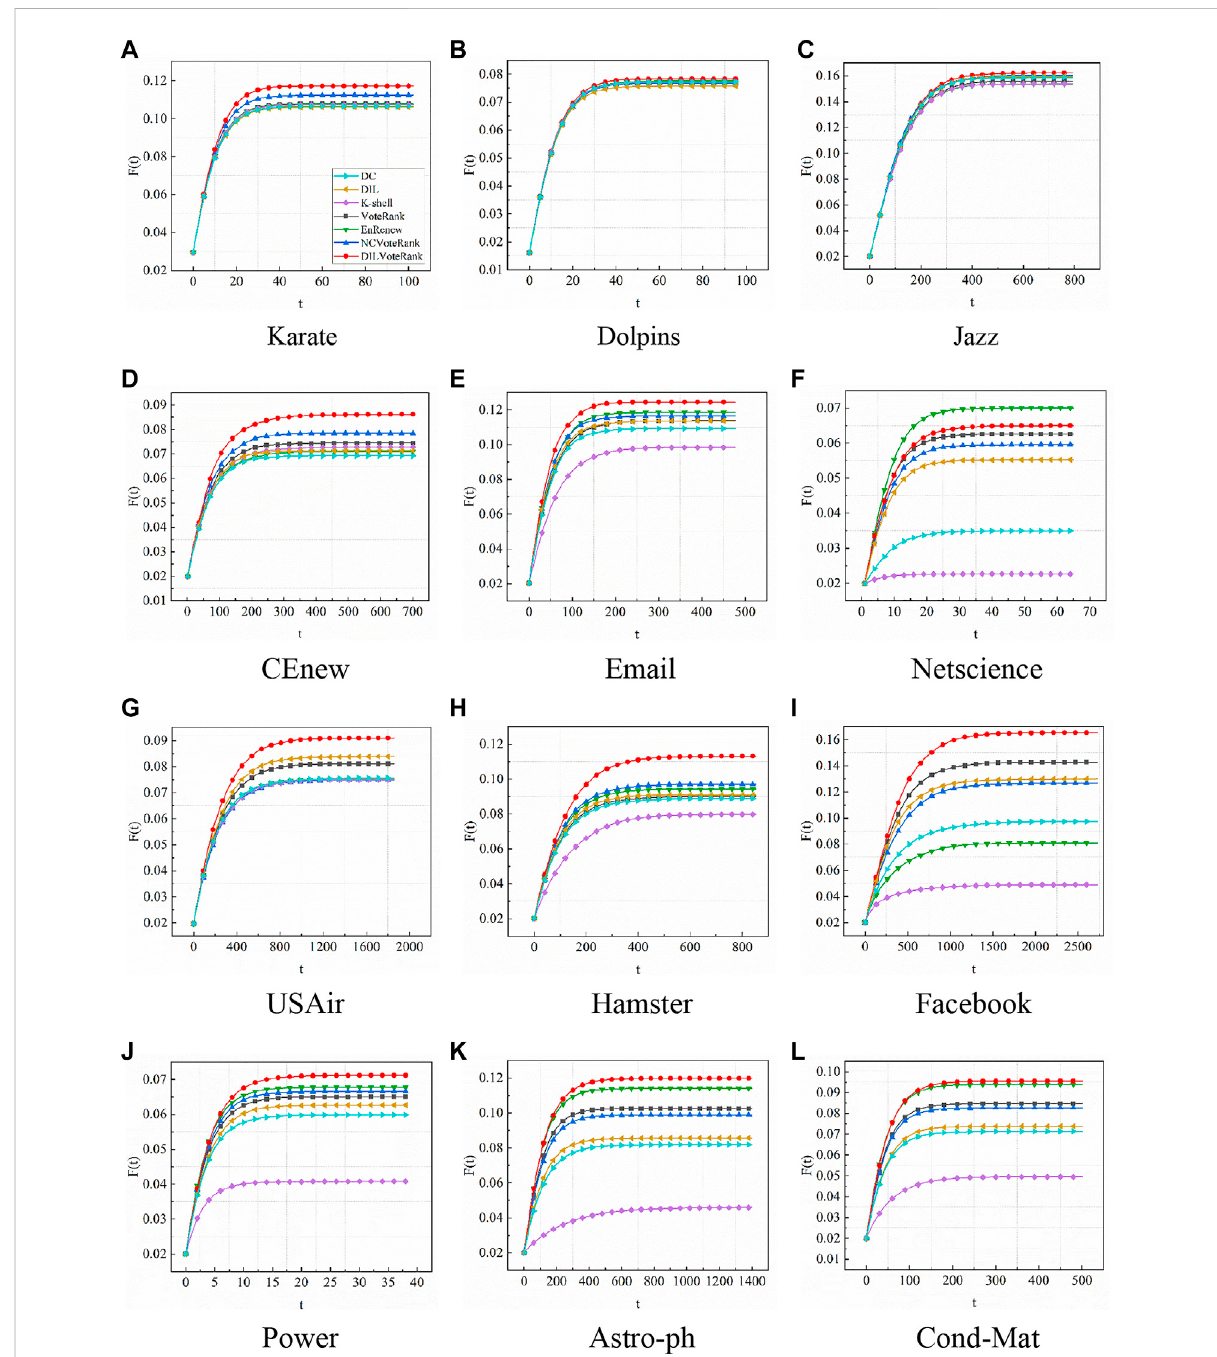
FIGURE 2 Theinfectionscale F ( t ) changecurveovertimeundertheSIRmodelwithdifferentalgorithms.Theexperimentalresultsaretakenastheaverage of 1,000 calculations, setting β (cid:2) 1 . 5 β th , infected rate ζ (cid:2) 1 . 25, and initial spreaders selection ratio ρ (cid:2) 0 . 02. Subgraphs (A – L) respectively represent the experimental results of 12 datasets in Table